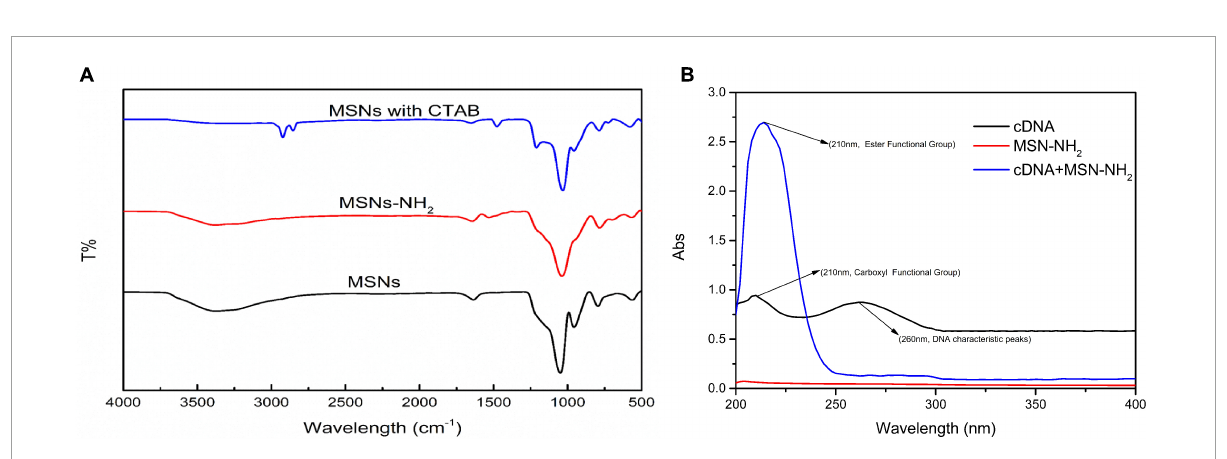
FIGURE3 (A) FTIR spectra of MSN-NH 2 , cDNA, and cDNA/MSN-NH 2 ; (B) UV-Vis spectra of supernatant of pure aptamer, aptamer/MSN, and aptamer/MSN-NH 2